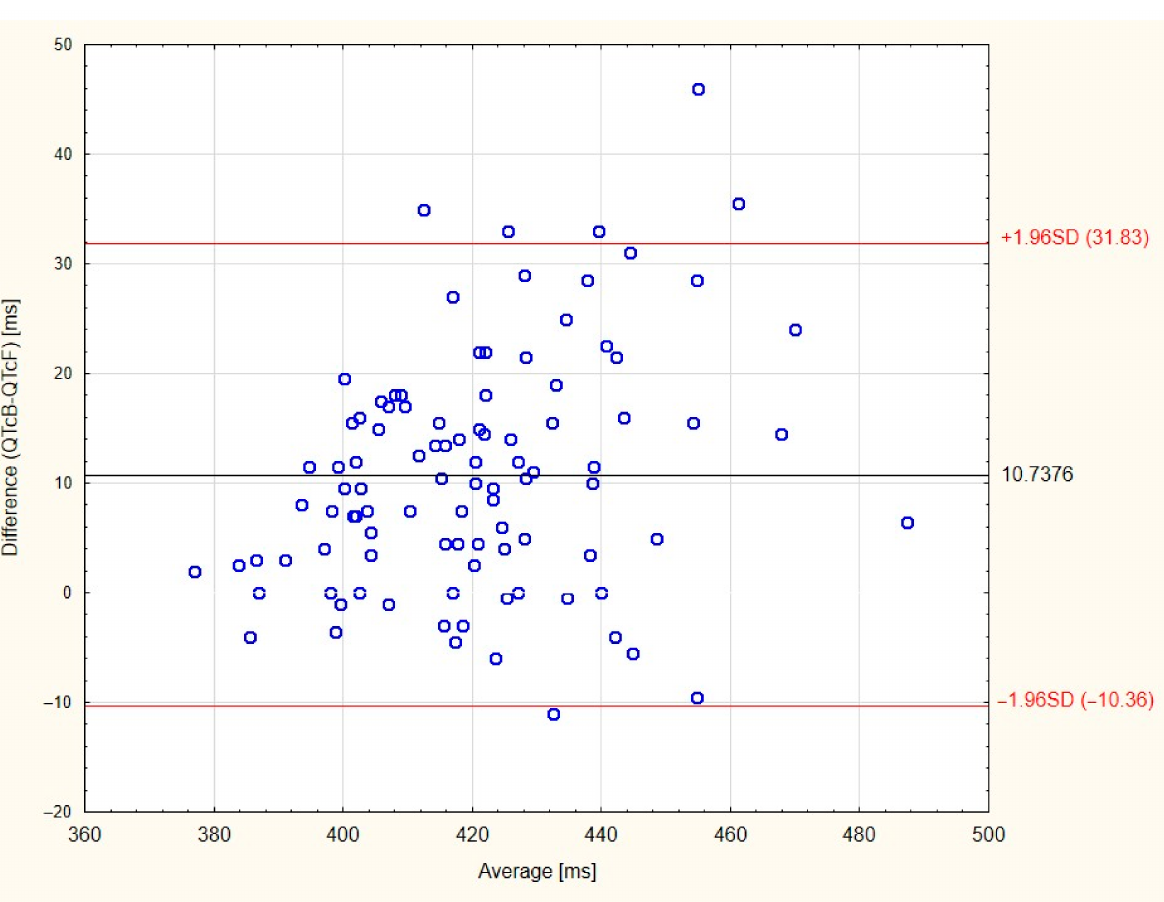
Figure 1. Bland–Altman diagram for QTcB and QTcF. Note: Black line-mean difference between QTcB and QTcF, red lines-95% limits of inter-rater